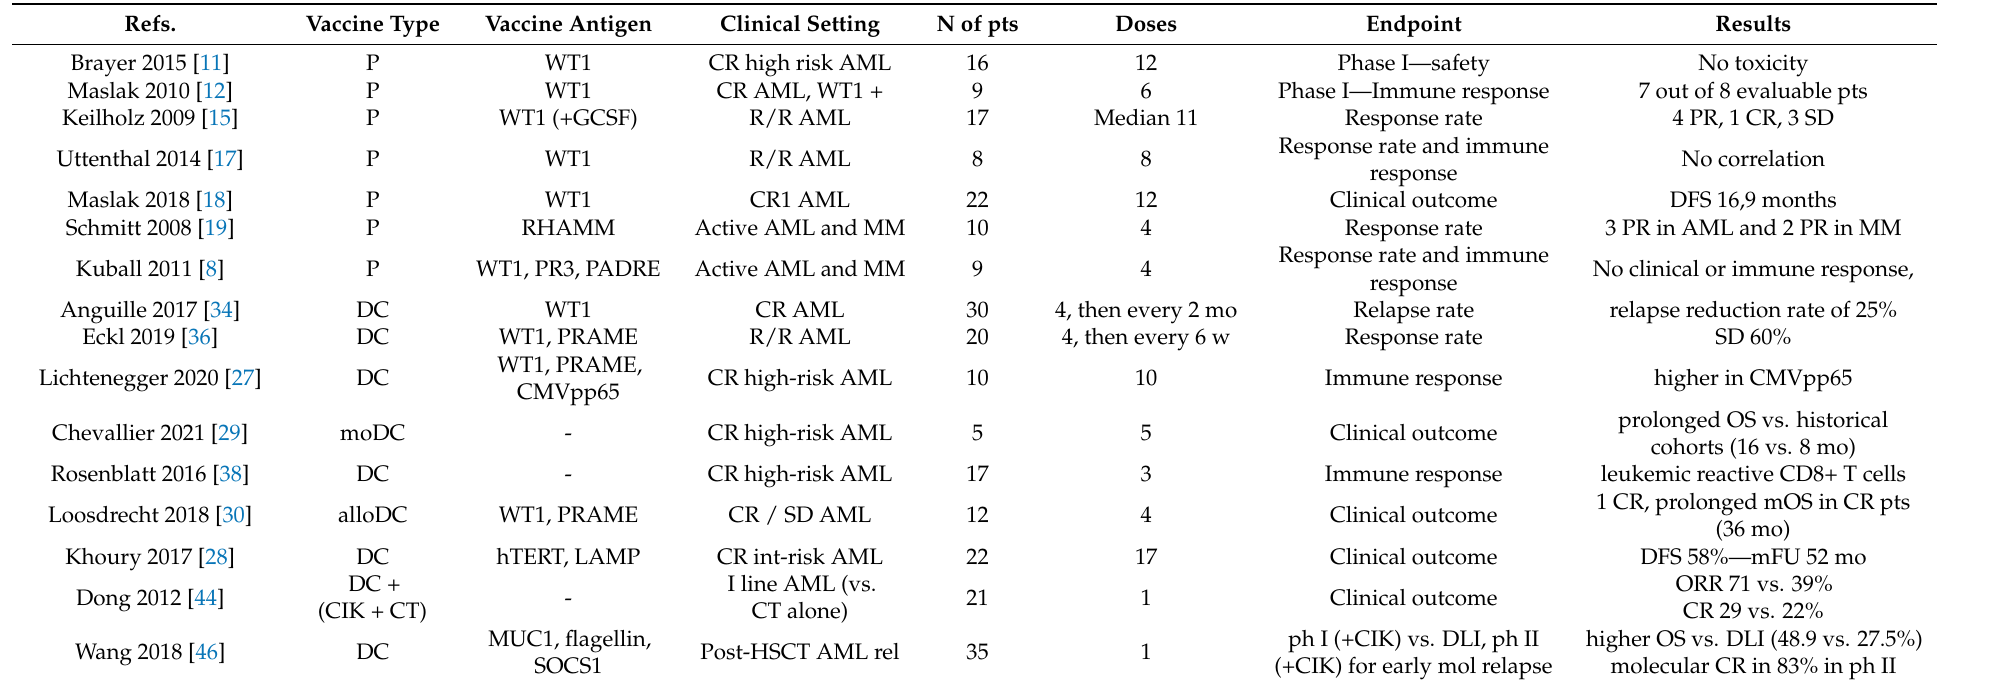
Table 1. Summary of the most relevant clinical trials available on vaccination therapy in AML. Ref, reference. P, peptide. DC, dendritic cell. Mo, monocyte. Allo, allogeneic. CIK, cytokine-induced killer cells. CT, chemotherapy. GCSF, granulocyte-colony stimulating factor. AML, acute myeloid leukemia. CR, complete response. R/R, relapsed/refractory. HSCT, hematopoietic stem cell transplant. N, number. PB, peripheral blood. DLI, donor lymphocyte infusions. Mol, molecular. PR, partial response. SD, stable disease. DFS, disease-free survival. MM, multiple myeloma. ORR, overall response. M, median. OS, overall survival. FU, follow-up.